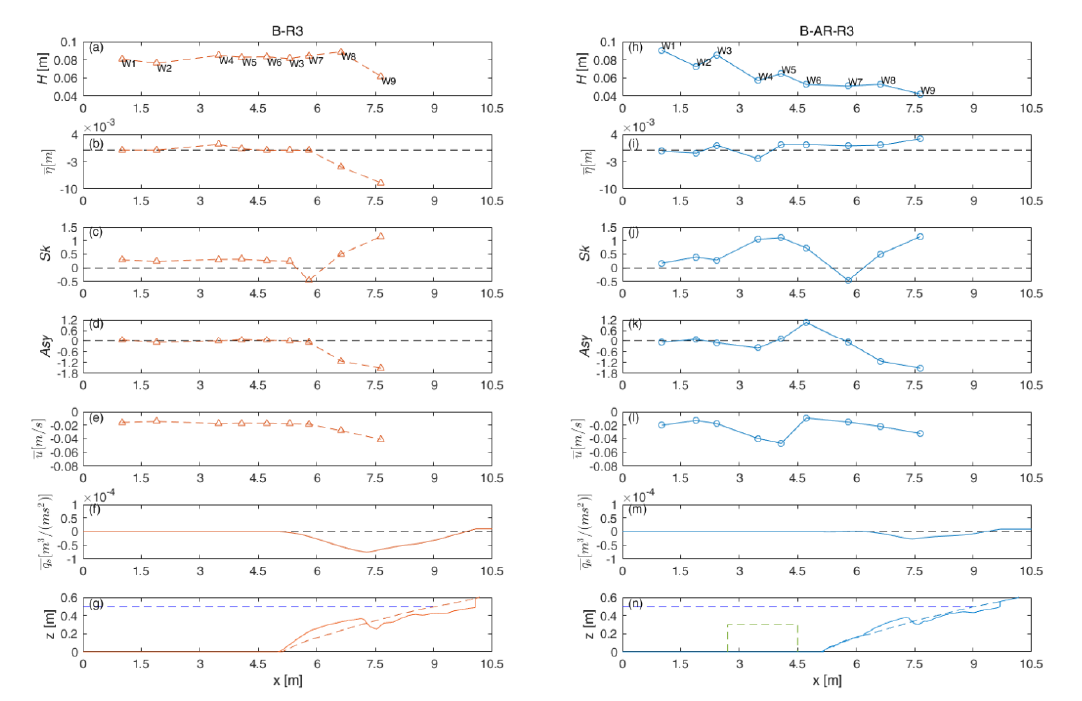
Figure 11. Cross-shore distribution of significant wave height H ( a , h ), mean water elevation η ( b , i ), wave skewness Sk ( c , j ), wave asymmetry Asy ( d , k ), undertow u ( e , l ), total sediment transport q s ( f , m ), initial (dashed) and final beach profile (solid) under wave R3. The final profiles ( g , n ) are the results from 20 min wave attack. The left panels ( a – g ) show factors in B-R3, and the right panels ( h – n ) show those in B-AR-R3. The green dash line rectangle in the right panel depicts the AR.